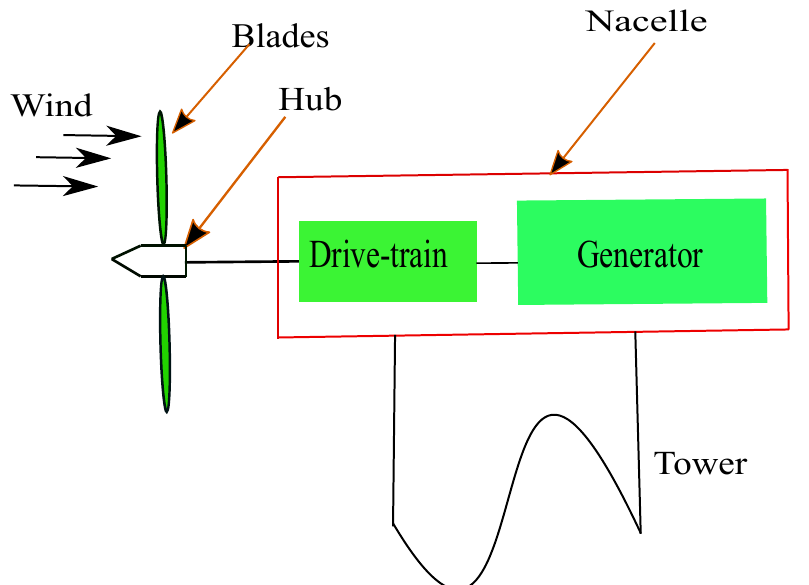
Figure 1. Horizontal axis variable speed wind turbine.